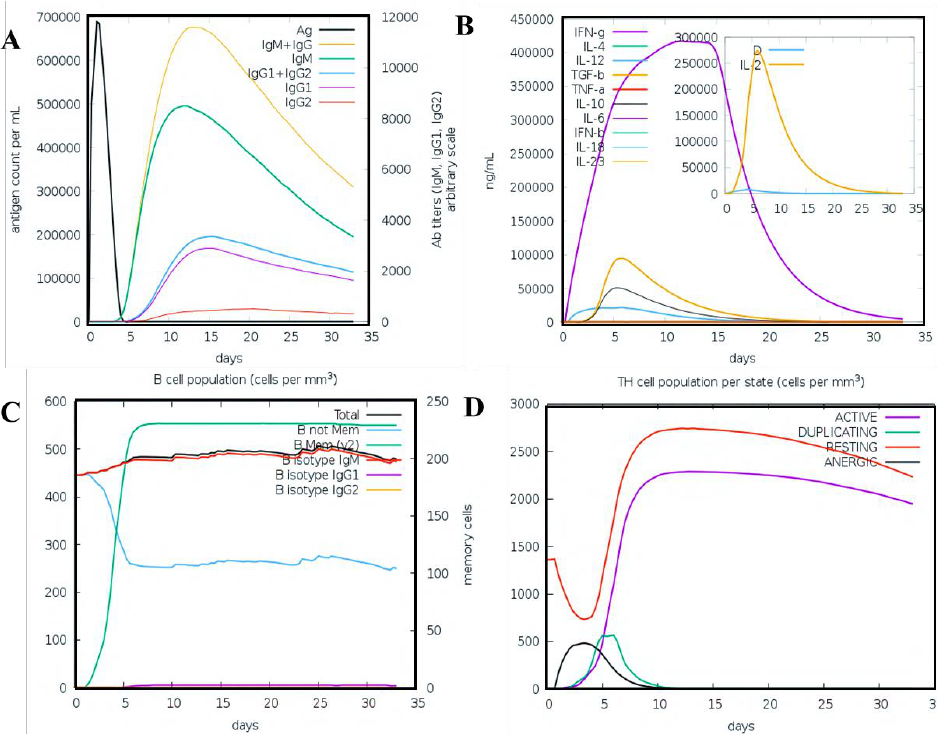
Figure 7. C-ImmSim presentation of an in silico immune simulation with the chimeric peptide. ( A ) Antibodies production (the black vertical lines are antigen). ( B ) Cytokine level ( C , D ) shows the B and T-cell populations, respectively.